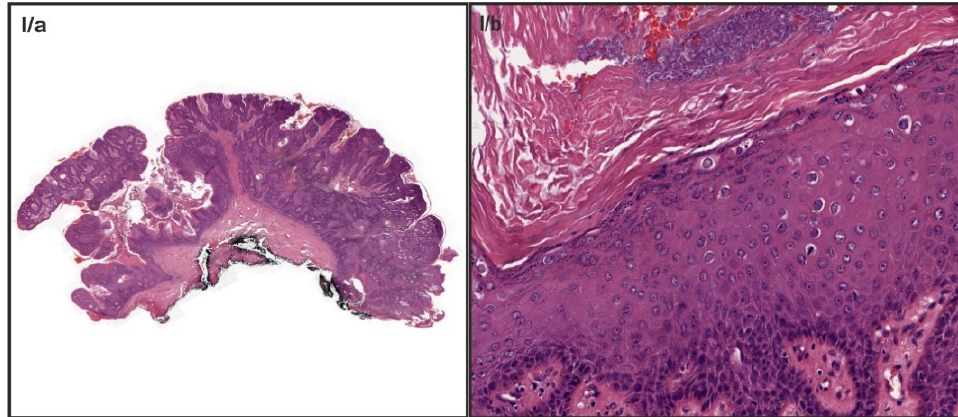
Figure 1. Histological characteristics of external genital warts. Note, the cauliflower-like architec- ture at the low power ( I/a ), Acanthosis, and parakeratosis with the presence of koilocytes in mid power image ( I/b